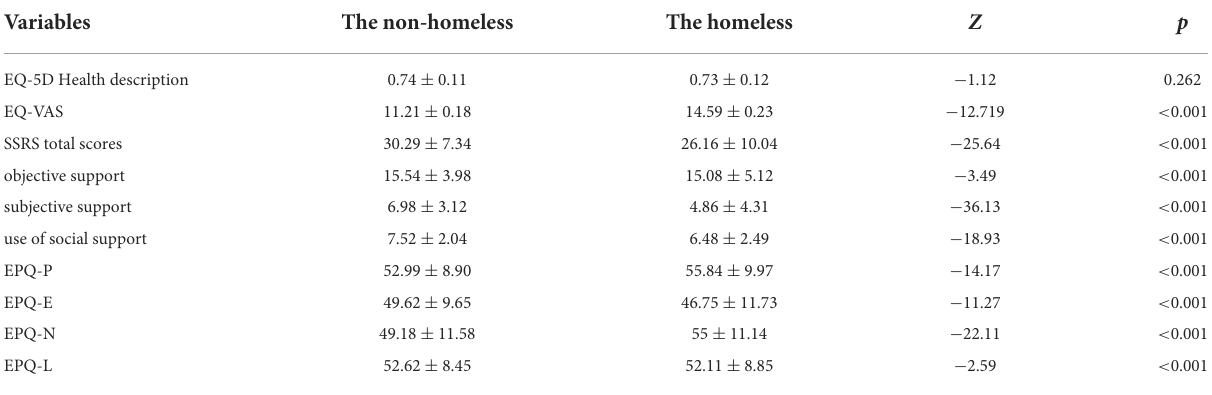
TABLE 2 Comparison of SSRS, EQ-5D, and EPQ differences between the homeless and non-homeless schizophrenia patients.